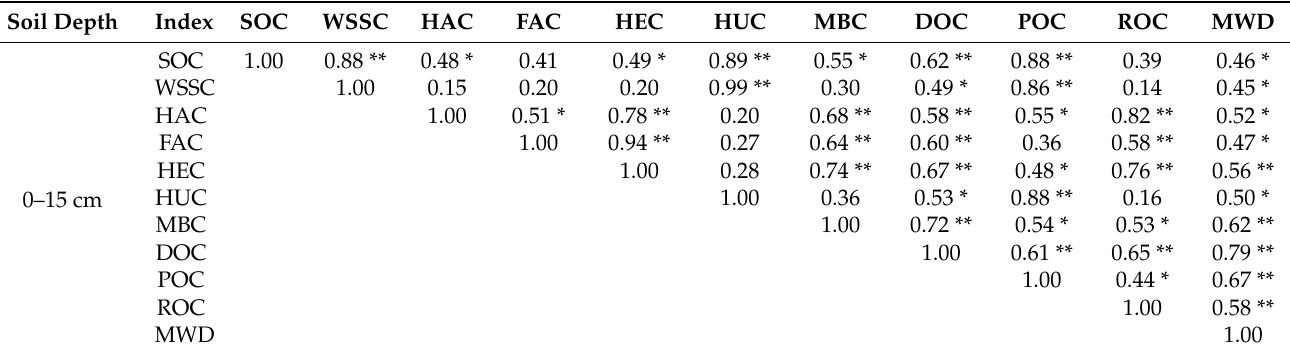
Table 4. Correlation matrix of soil organic carbon (SOC), water-soluble substance carbon (WSSC), humic acid carbon (HAC), fulvic acid carbon (FAC), total alkali-extractable humus carbon (HEC), humin carbon (HUC), microbial biomass carbon (MBC), dissolved organic carbon (DOC), particle organic carbon (POC), KMnO 4 -oxidizable carbon (ROC) contents and mean weight diameter (MWD) at 0–15 and 15–30 cm depths as affected by different treatments in 2020 after 12 years of annual fertilization. * p < 0.05, ** p < 0.01.